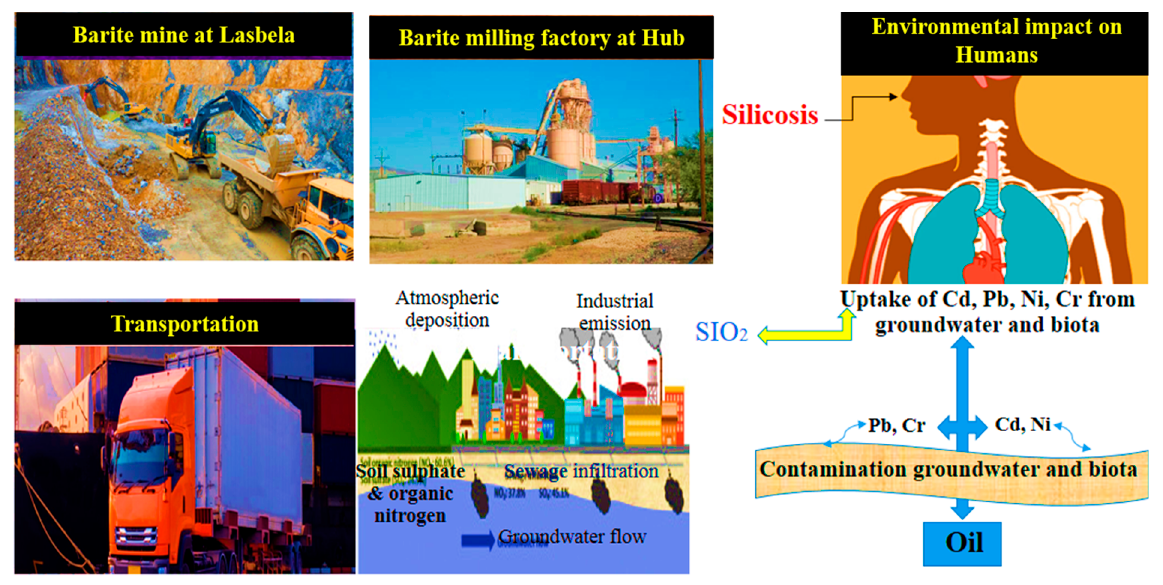
Figure 1. Map showing the research area of Lasbela, coastal region of Baluchistan, Pakistan.